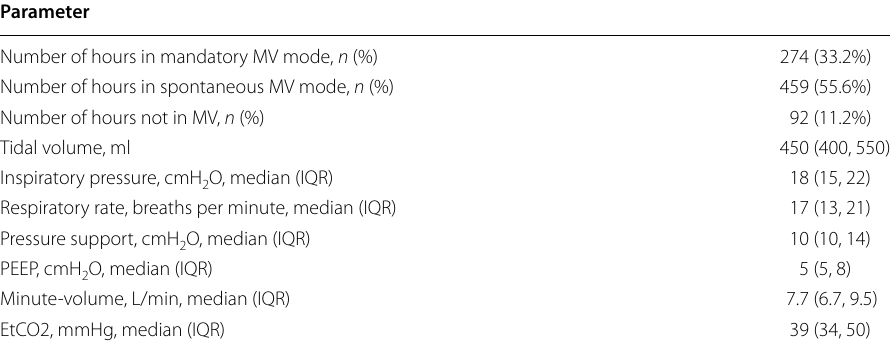
Table 2 Mechanical ventilation parameters of human patients Parameter